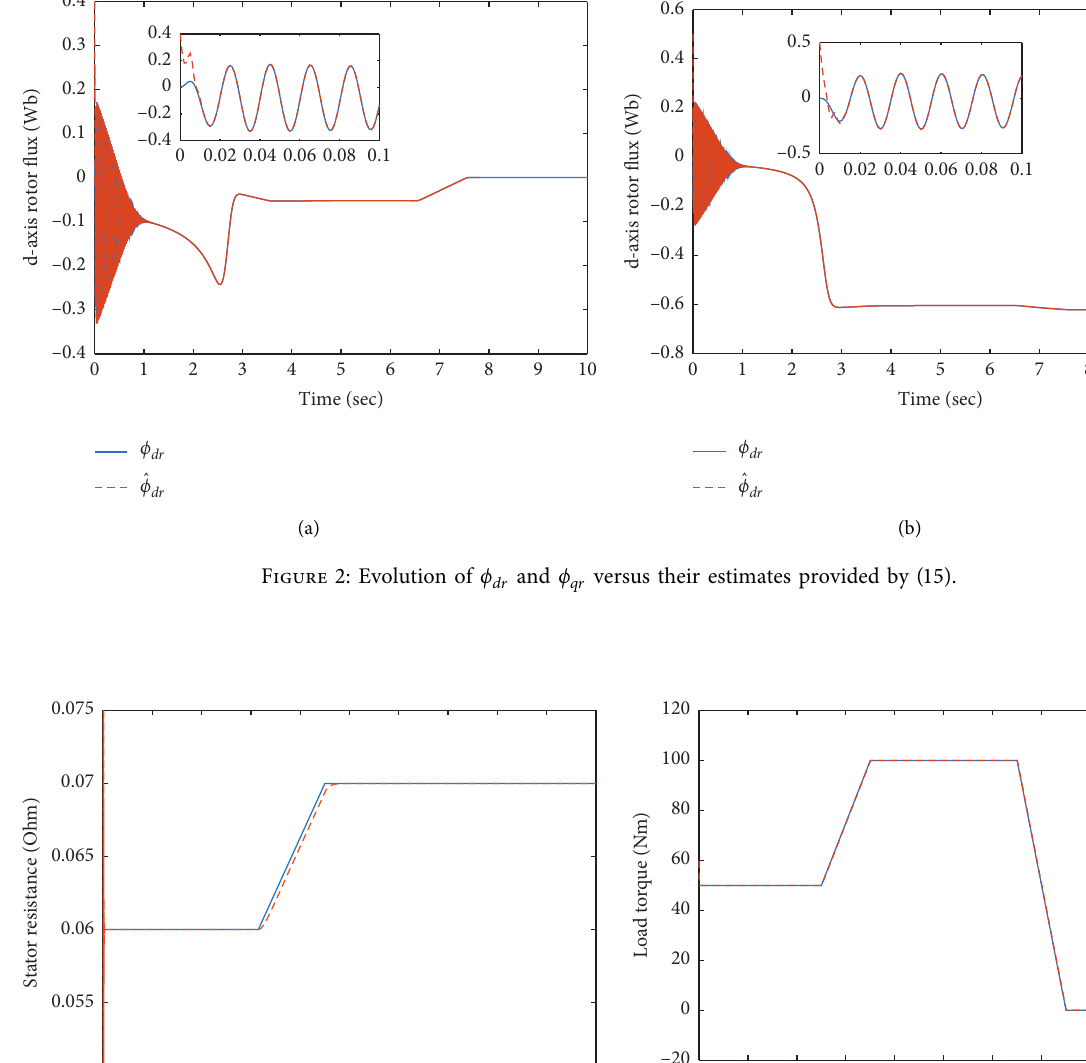
T , respectively, and of their estimates given by observer s and L